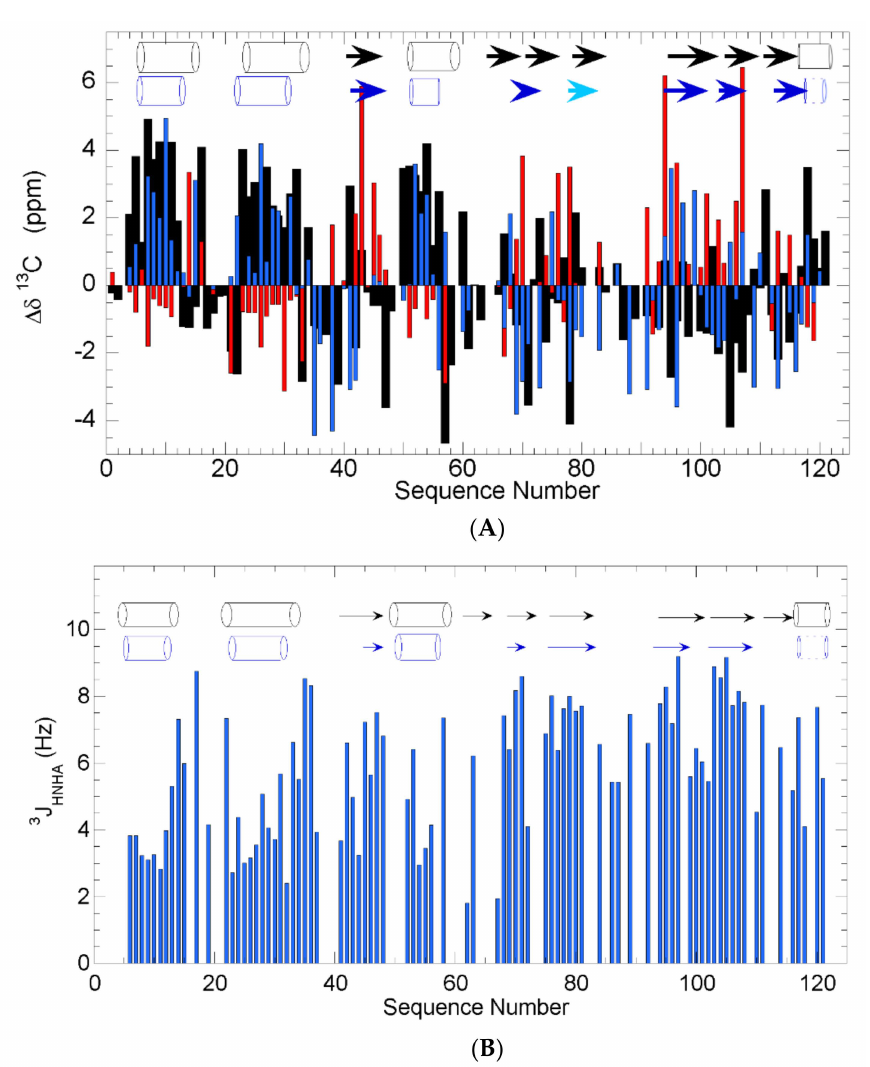
Figure 2. ( A ). Secondary structure from Chemical Shifts. The conformational chemical shifts of 13 C α (black bars), 13 C β (red bars) and 13 CO (blue bars) are shown. Based on the CSI rules [39], segments of secondary structure are identified and shown in blue as cylinders for helices and arrows for β -strands. The β -strand spanning residues 78–83 and the C-terminal helix, whose identification is doubtful, are shown in a lighter tone of blue and with broken lines, respectively. ( B ). 3 J NHHA coupling constants for WT h-ANG at 35 ◦ C in pH 6.5 NaH 2 PO 4 /Na 2 HPO 4 (NaPi) buffer (blue bars). The segments defined as secondary structural elements by X-ray crystallography (PDB 1ANG) and 3 J NHHA couplings are shown in black and blue, respectively, as cylinders for helices and arrows for β -strands. The short 3 10 helix (blue dotted lines) is doubtful, as only residues 118 and 121 show low 3 J NHHA